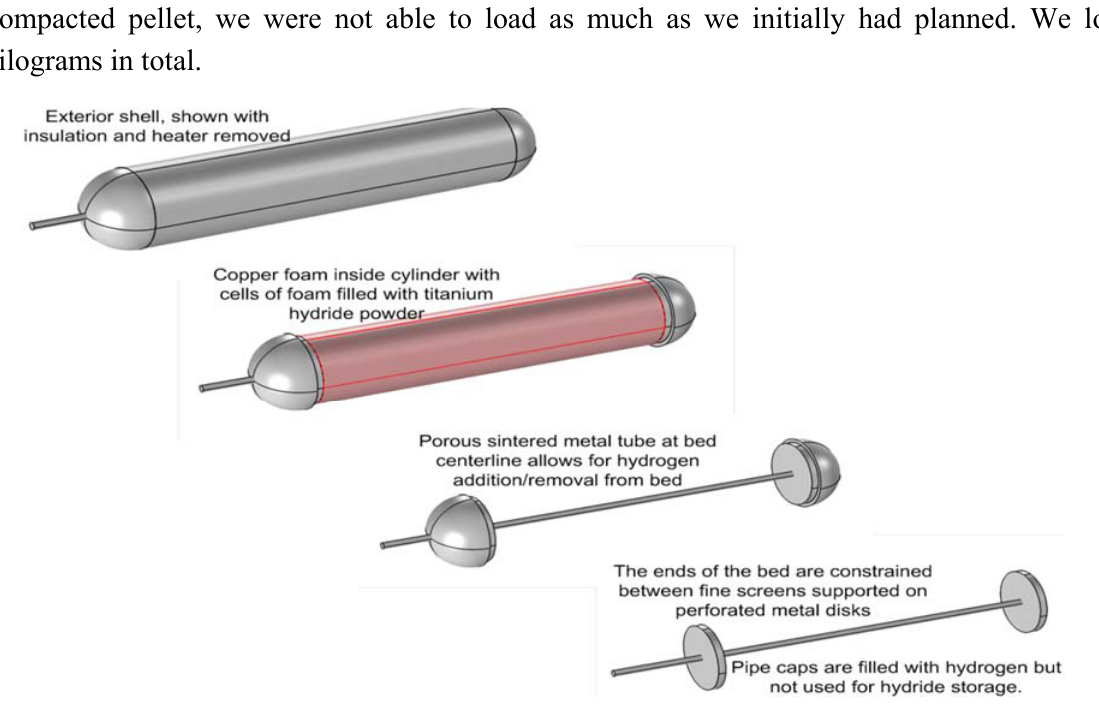
Figure 16. Internal structure of the hydride test